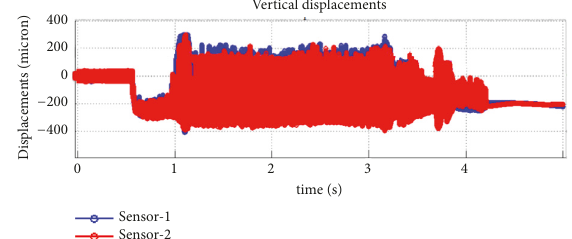
Figure 23: Rotor vertical displacements during a radial landing experimental test at DE (blu line) and NDE (red line) rotor nodes.